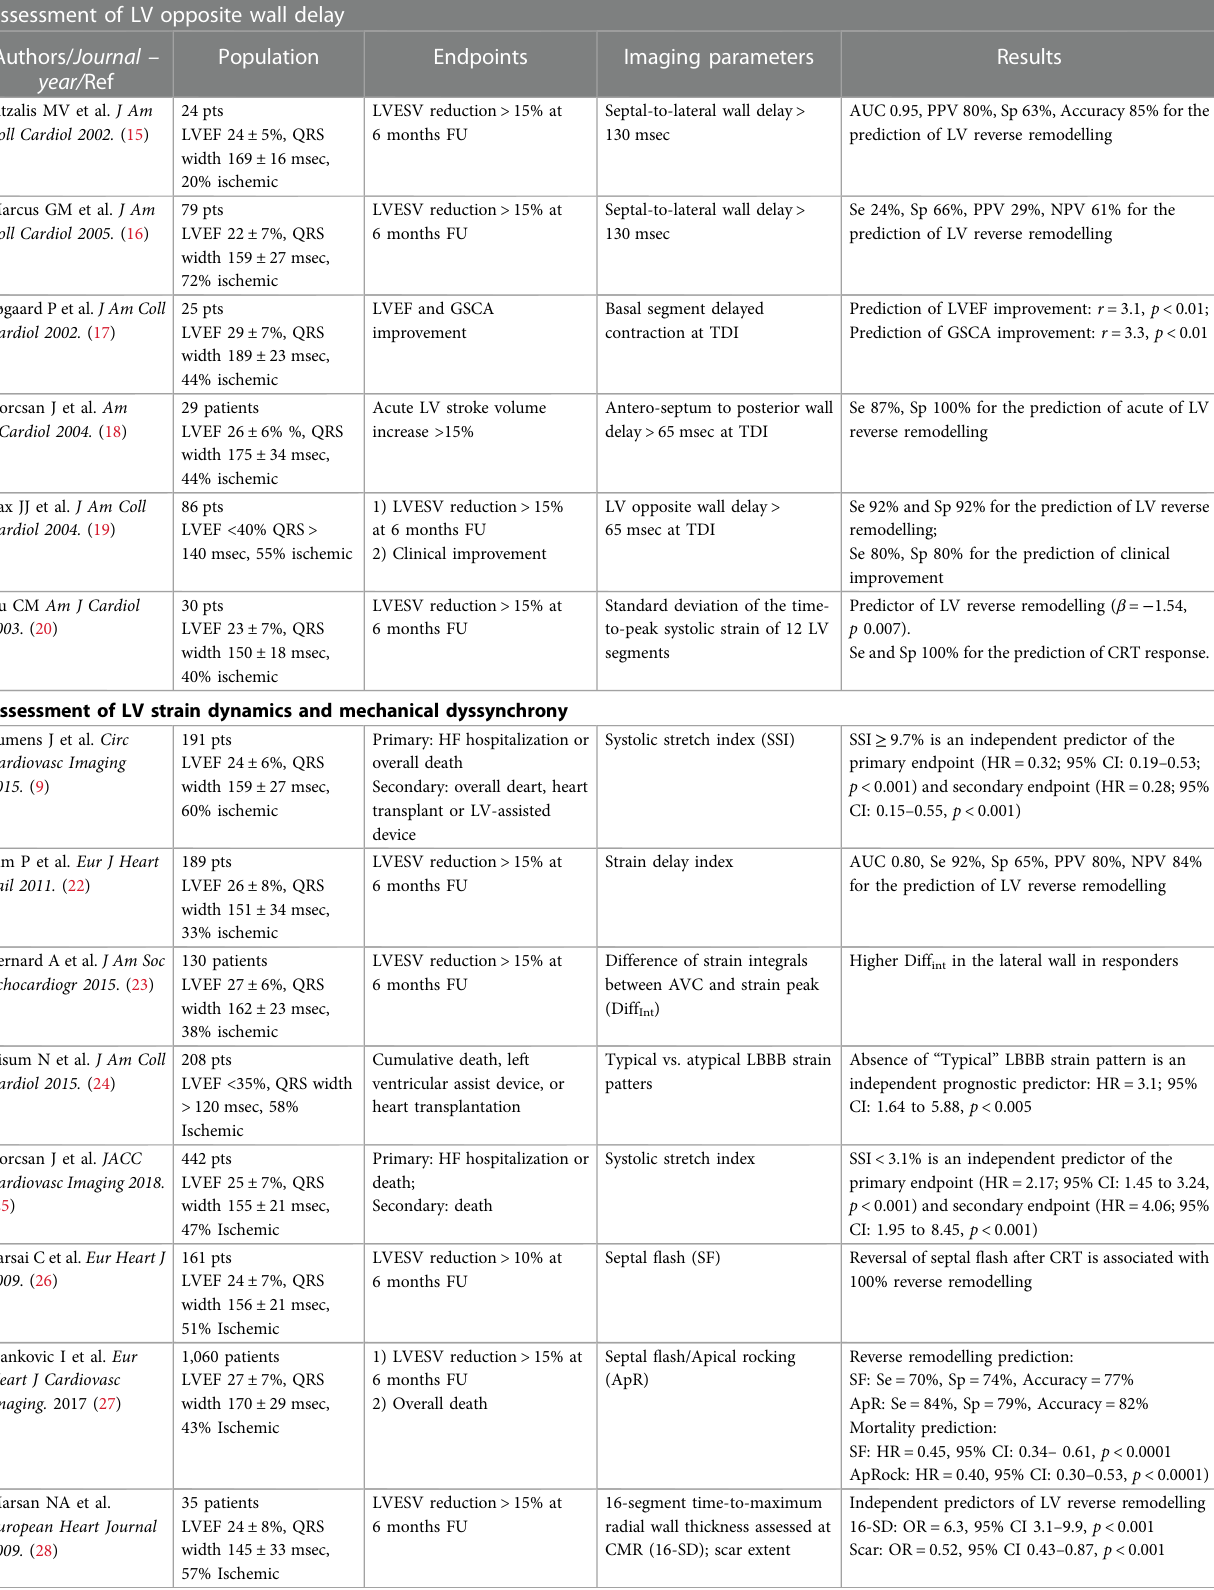
TABLE 1 Summary of the main cited studies providing an overview of the role of imaging-derived parameters modalities in the fi eld of